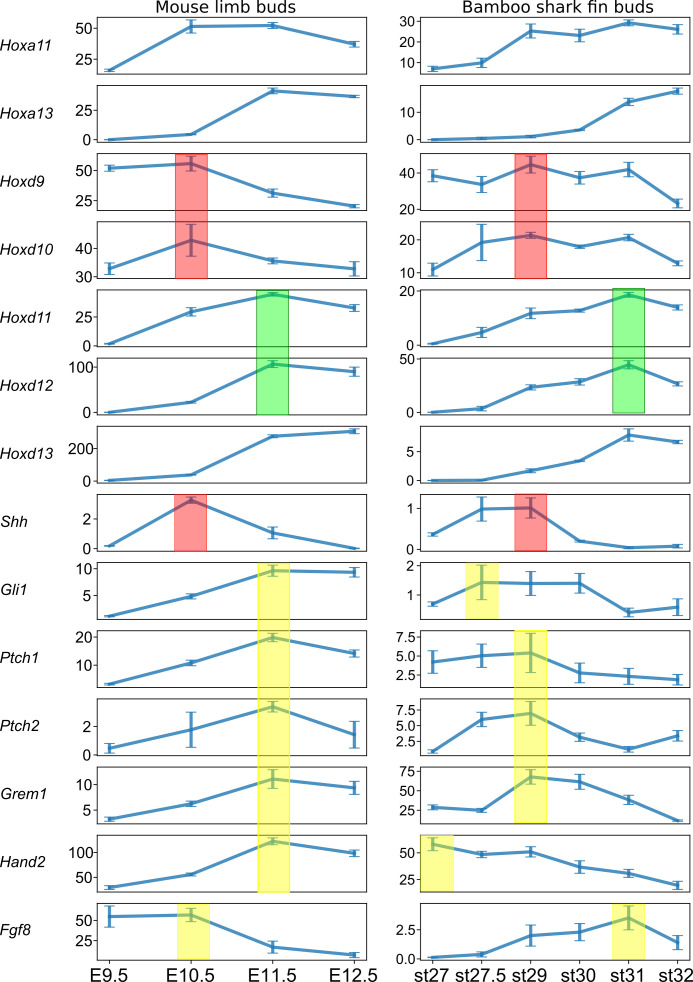
The temporal dynamics of the Shh pathway based on intact TPM values.Red filled rectangles, the expression peak of Shh, Hoxd9, and Hoxd10; yellow filled rectangles, the expression peak of Shh target genes; green filled rectangles, the expression peak of Hoxd11 and Hoxd12.